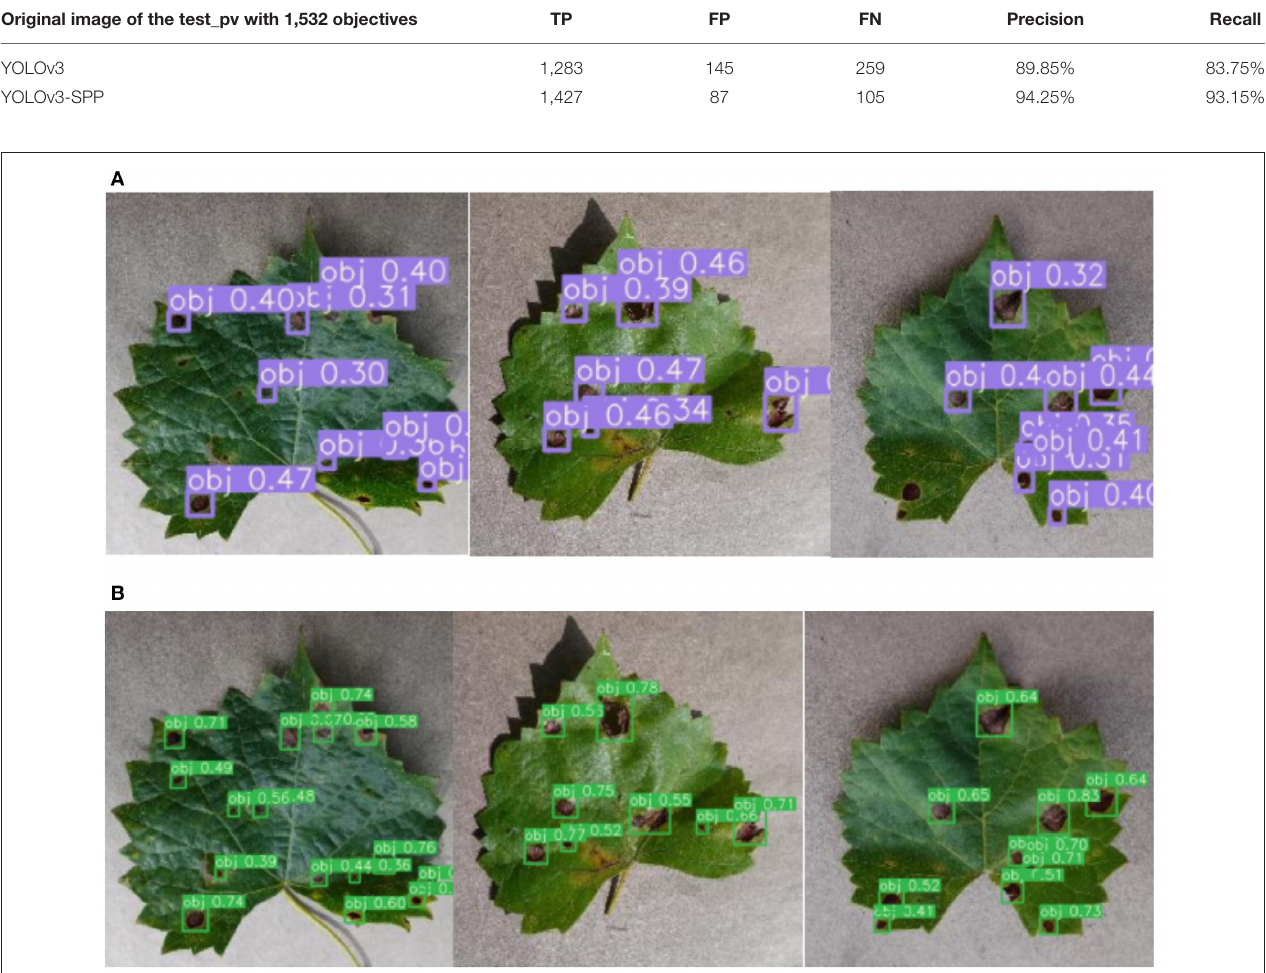
FIGURE 8 | The comparison of detection results before and after the improvement of YOLOv3 network. (A) The detection results of the original YOLOv3 for original images. (B) The detection results of the improved YOLOv3-SPP for original images.